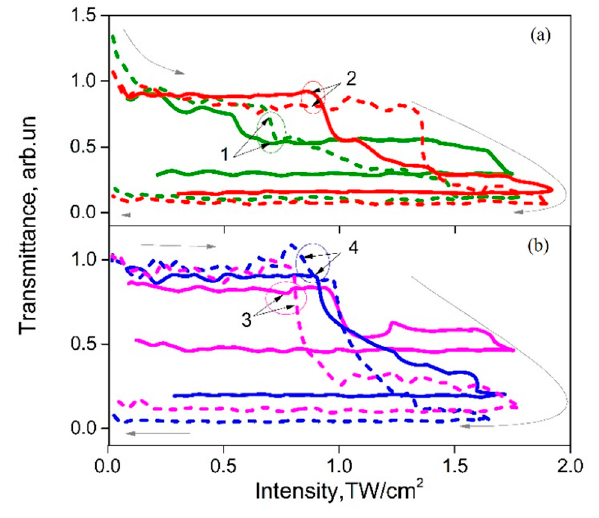
Figure 5. The photoinduced variations of total (solid line) and on-axis (dashed) transmittances versus the peak laser intensity at 1064 nm for the samples of P(VDF-TrFE) copolymer with different thicknesses: (1) 1.0 µm, (2)—1.2 µm, (3)—1.3 µm, (4)—1.5 µm. ( a ) Comparison of unpoled (1) and poled (2) samples. ( b ) Comparison of samples with different thickness. Arrows indicate the influence of the increase intensity up to threshold and consequent decrease.